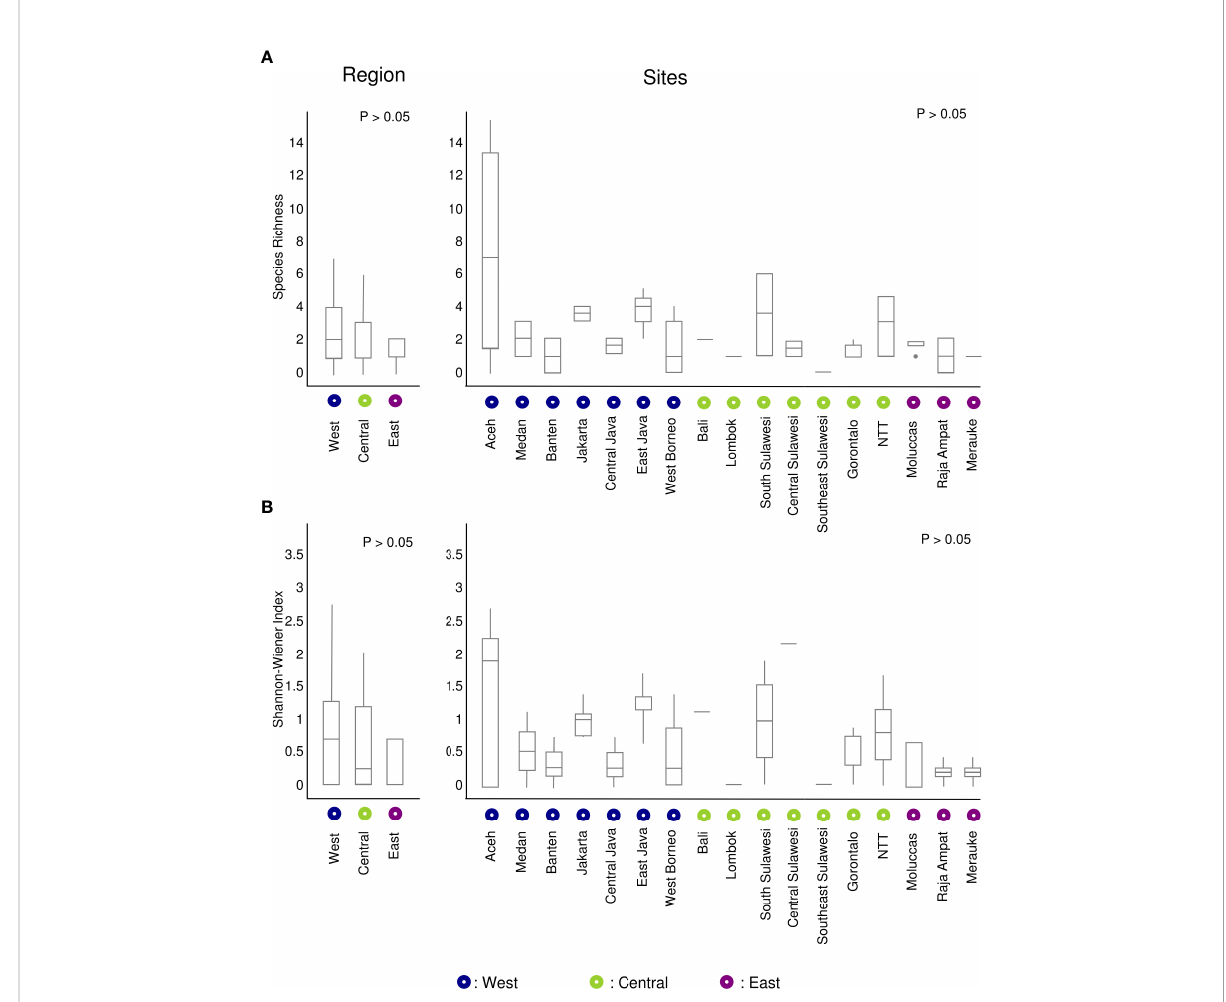
FIGURE 6 Boxplot representing alpha diversity based on the number of OTUs identi fi ed at species level: (A) Species richness, and (B) Shannon-Wiener